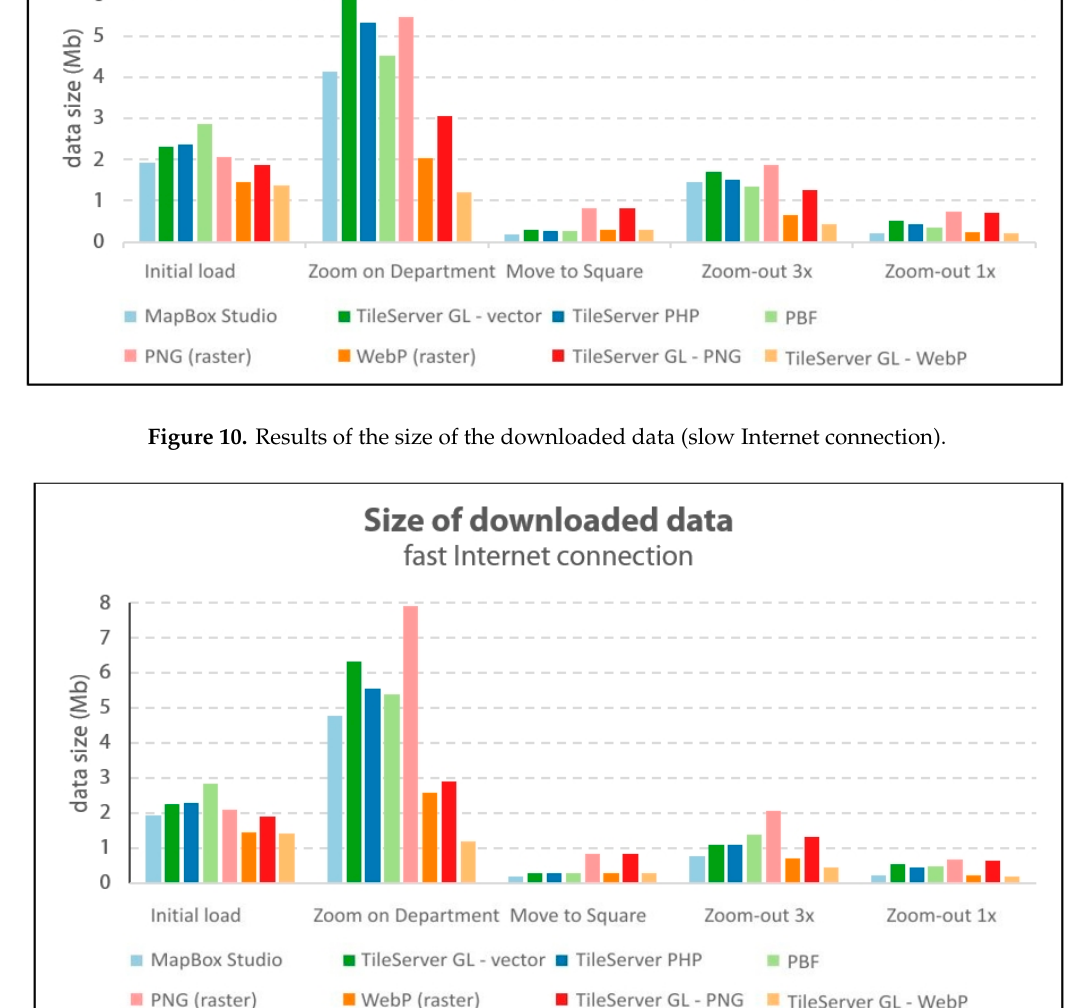
Figure 11. Results of the size of downloaded data (fast Internet connection).